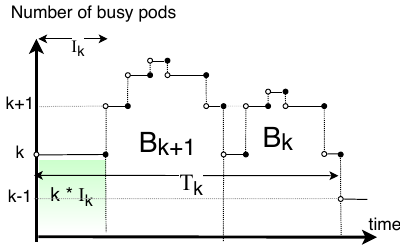
Figure A1. Illustration for the recursive definition of B k